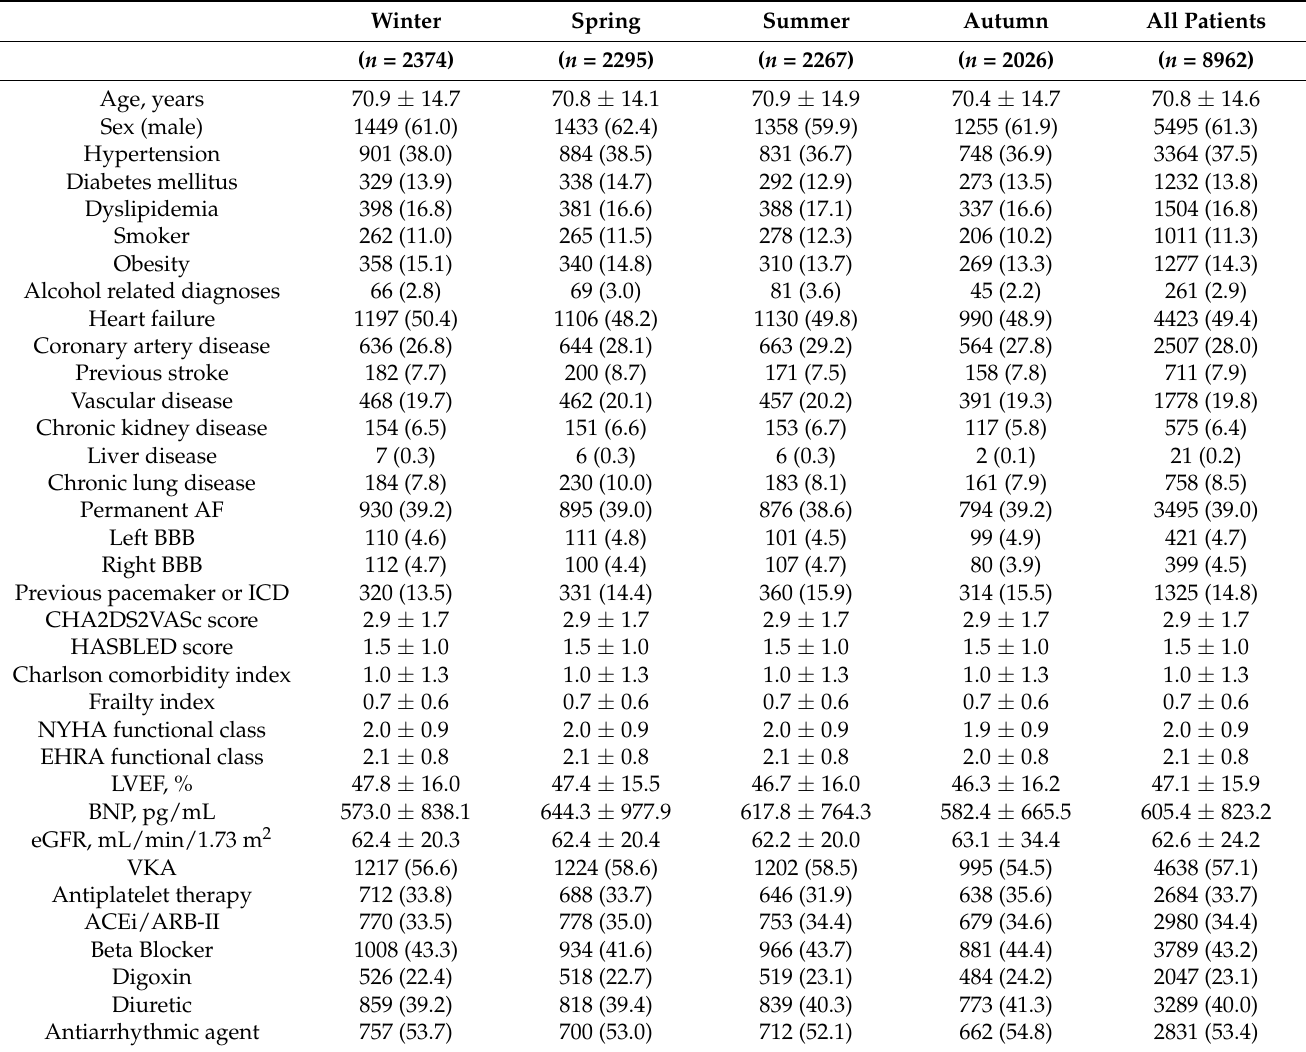
Table 1. Baseline characteristics according to season of birth. Winter Spring Summer Autumn All